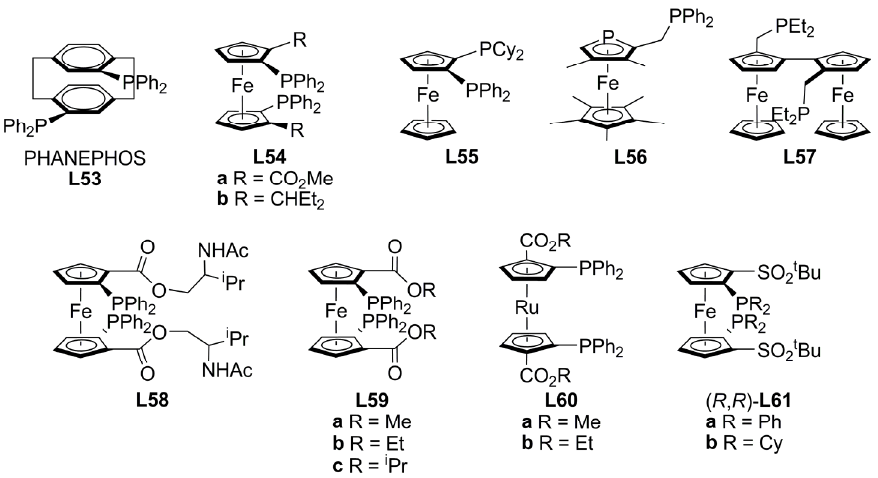
Figure 21. Diphosphines with planar